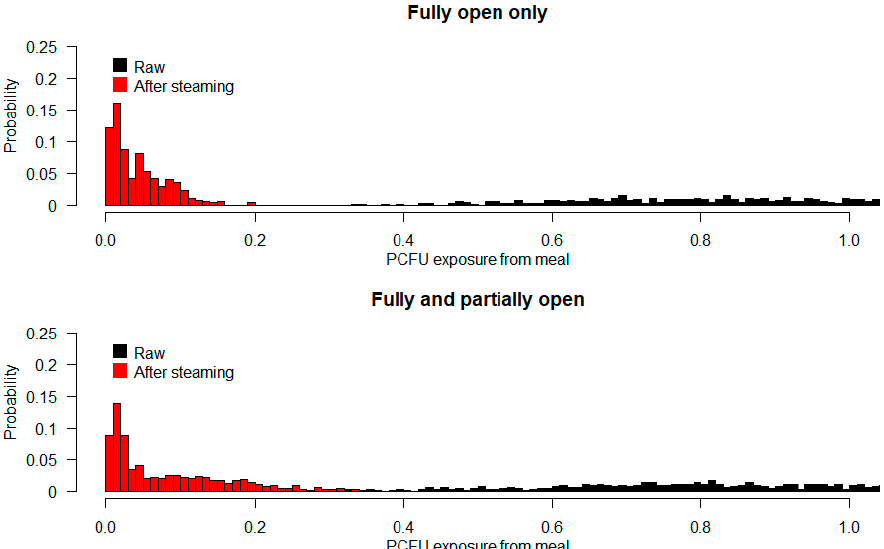
Figure 3. Simulated doses of E. coli in a meal size consisting of 20 randomly drawn open mussels ( top panel) as a proportion of original (un-steamed) contamination (Equation (2)). The red bars are a histogram of such meals consisting of mussels steamed to opening, compared to the load from a similar number of raw shells (black bars). The risk is markedly higher if partially opened mussels are included in the meal at the same frequency they were found in this experiment ( bottom panel).